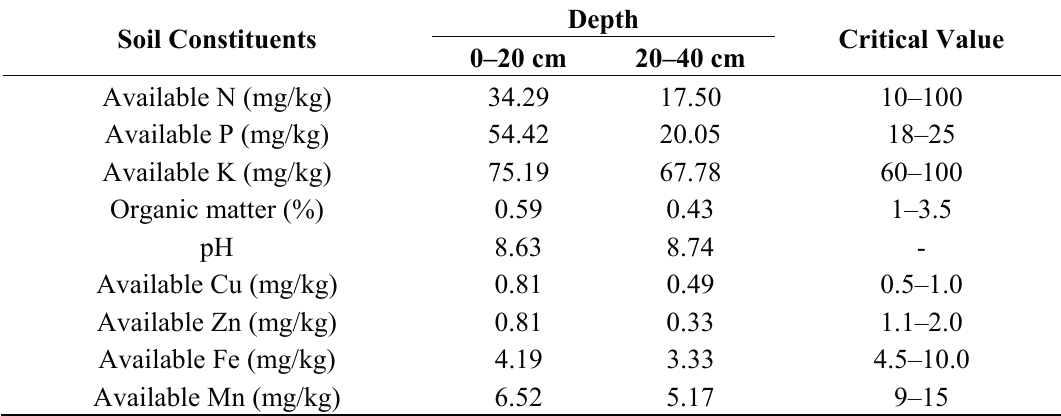
Table 1. Soil constituents of the experimental field